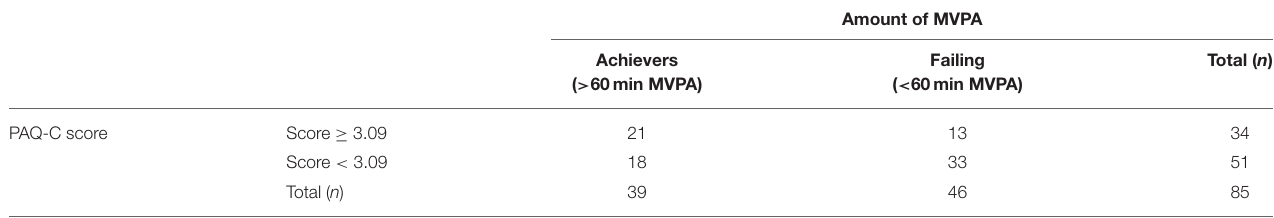
TABLE 3A | Classification matrix of the PAQ-C to distinguish the amount of children ( n ) who did and did not achieve the minimum recommended daily MVPA level of 60min [WHO activity guideline for children (6)].